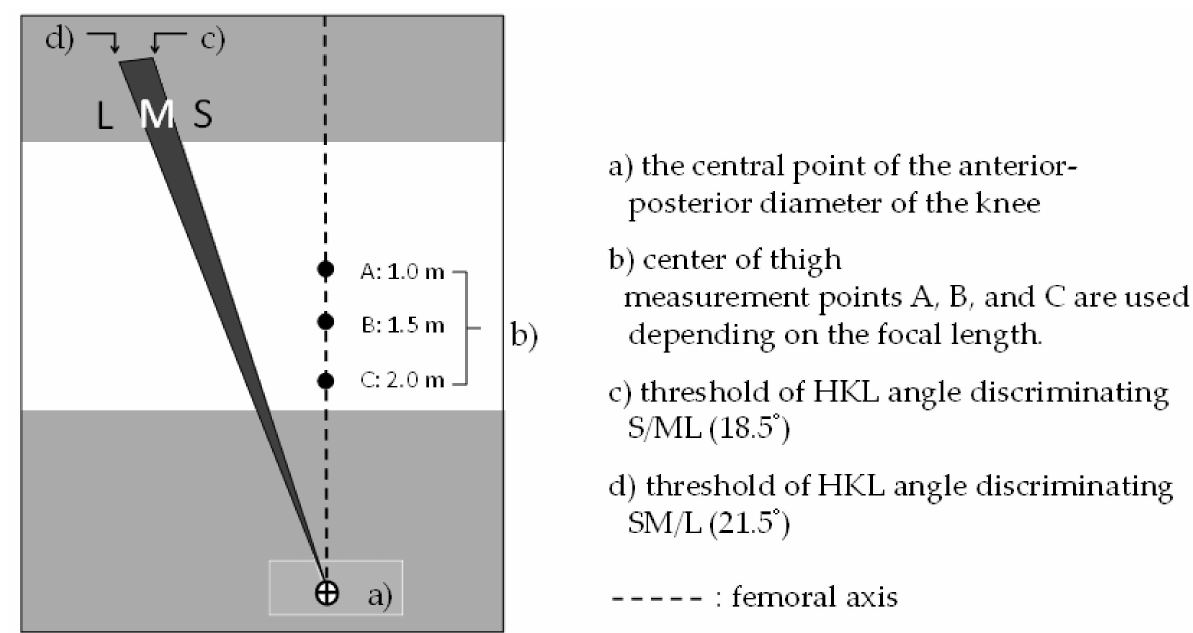
Figure 3. Practical PI classification tool using the HKL